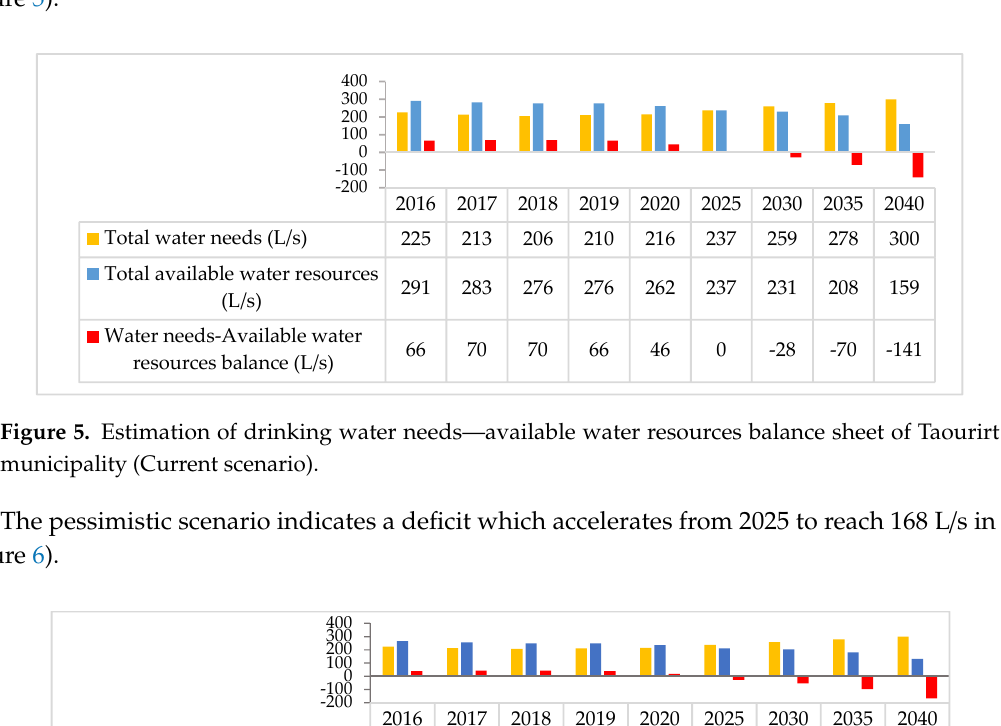
Figure 4. Estimation of drinking water needs—available water resources balance sheet of Oujda municipality (Pessimistic scenario).